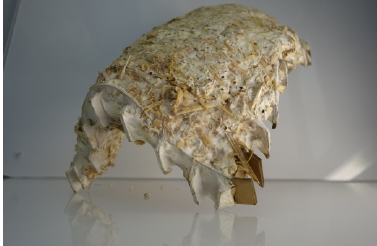
Figure 16. Possible combination of basket structures for column-like elements.